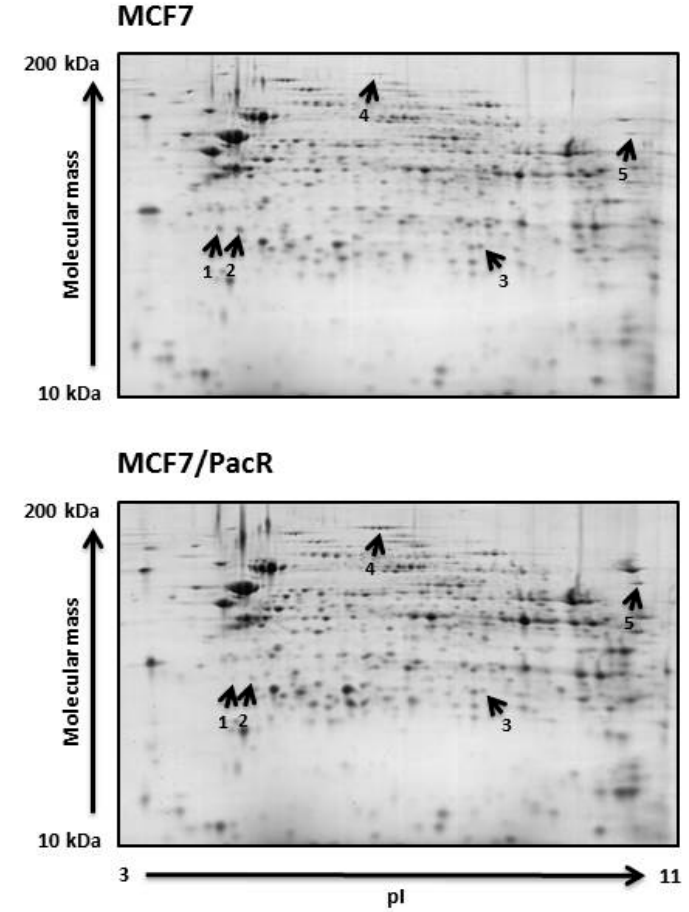
Figure 2. Differences between paclitaxel-sensitive MCF7 cells and paclitaxel-resistant MCF7/PacR cells concerning protein expression in high-purity mitochondrial fractions. Representative 2D gels of three independent pairs of gels (see Section 4) show five spots with differing expression (at least two-fold change). These five spots were identified as cathepsin D (spot 1 and spot 2), ABHD11 (abhydrolase domain-containing protein 11) (spot 3), CPS1 (carbamoyl-phosphate synthetase 1) (spot 4), and ATAD3A, ATAD3B (ATPase family AAA domain-containing protein 3A and 3B) (spot 5).